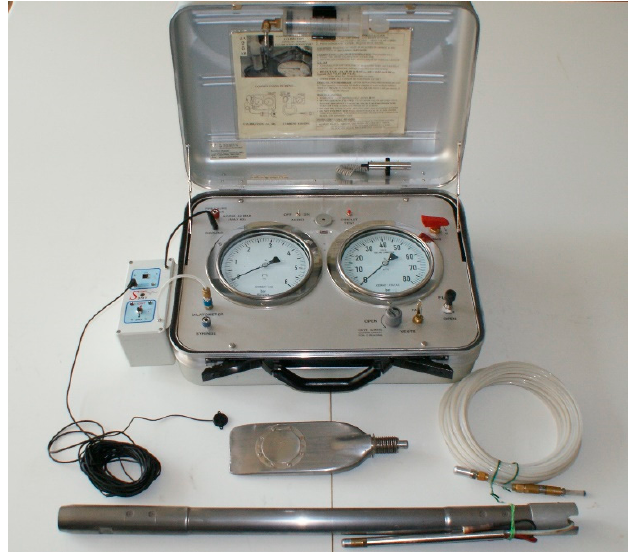
Figure 1. Dilatometer blade, measuring unit and seismic module of the seismic dilatometer test